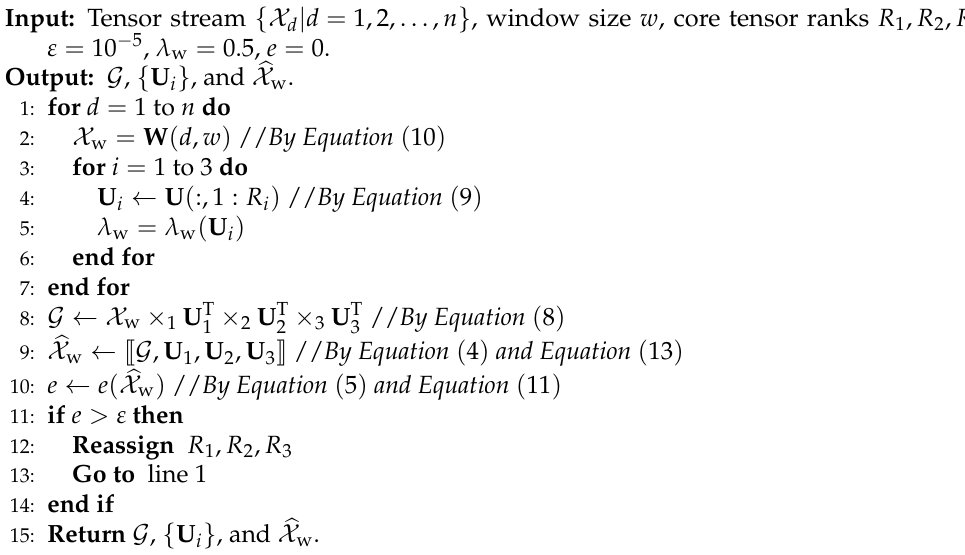
Algorithm 1 Sliding-window-based tensor stream analysis algorithm